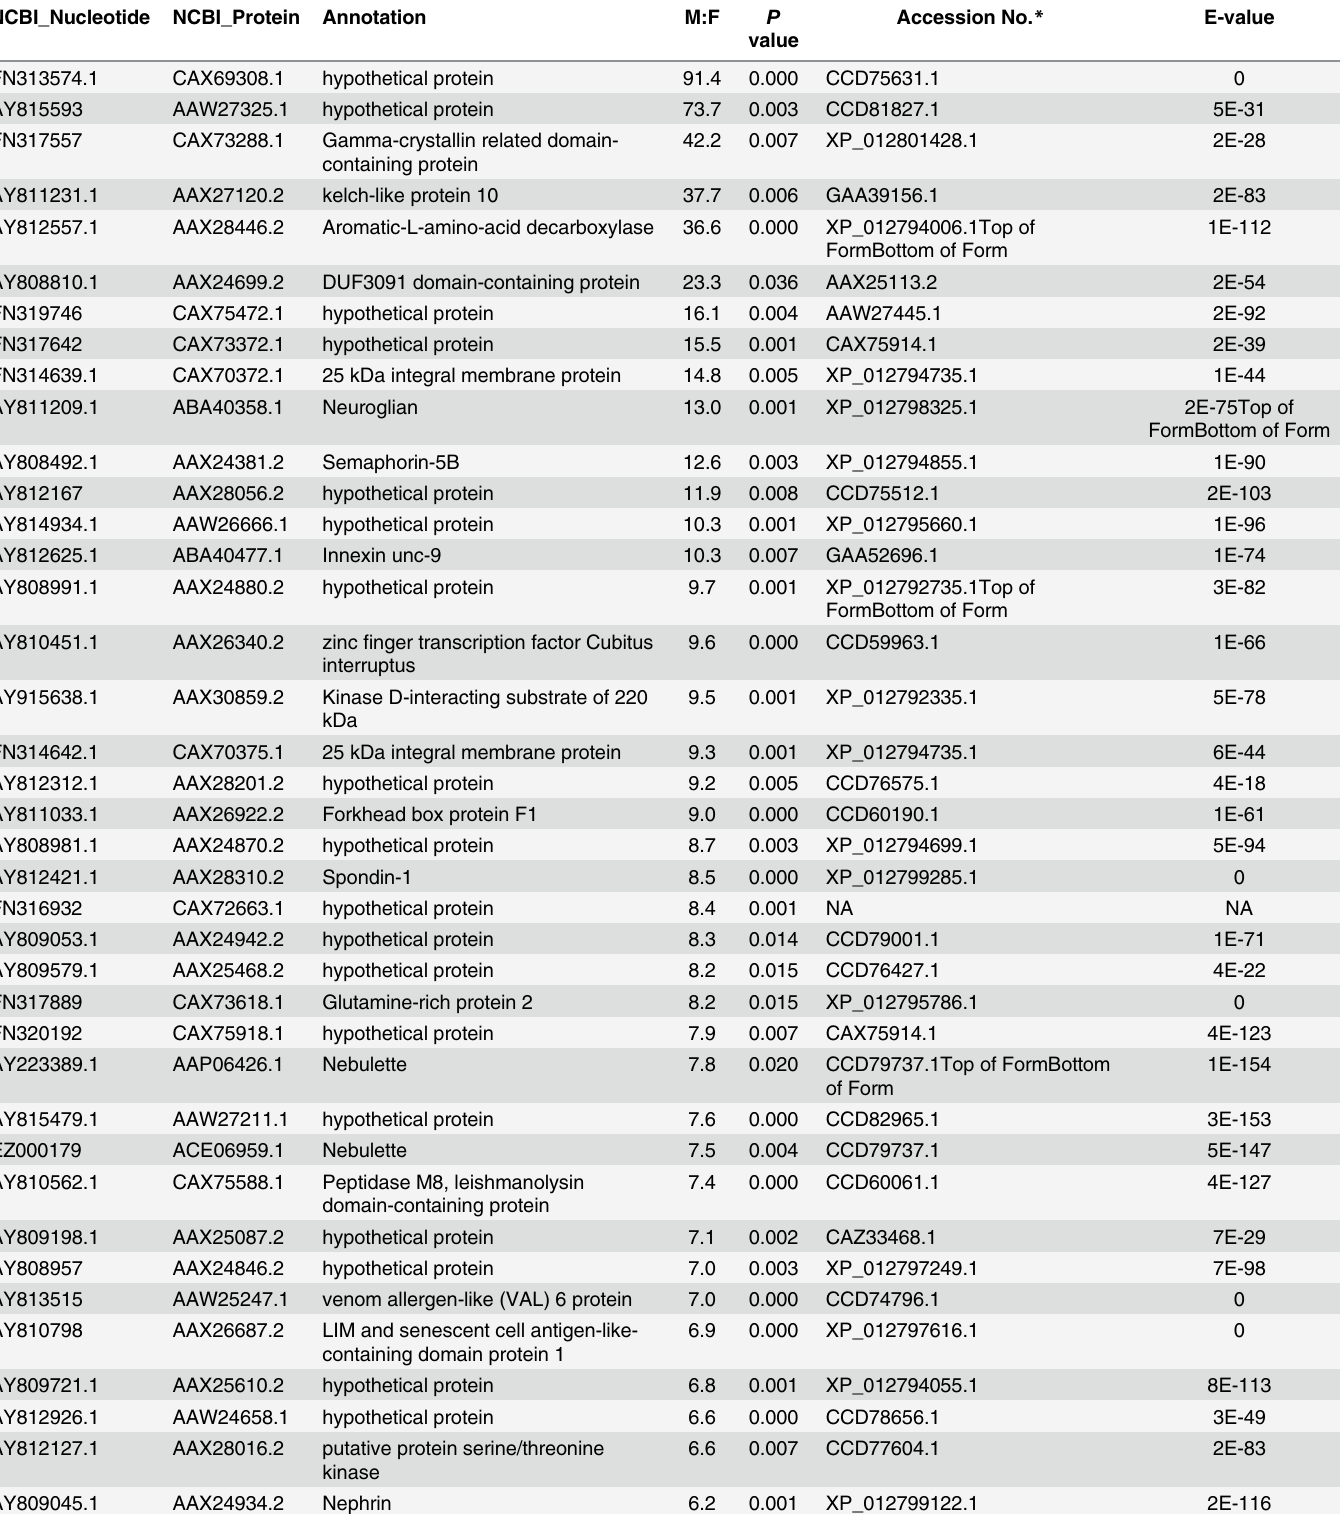
Table 2. Top 40 adult male-biased expressed genes in S .